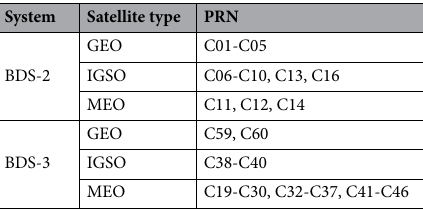
Table 1. Operational BeiDou System satellites in orbit. The last launched BDS-3 GEO satellite C61 is not included, because it is still in the in-orbit testing phase when the paper is completed.